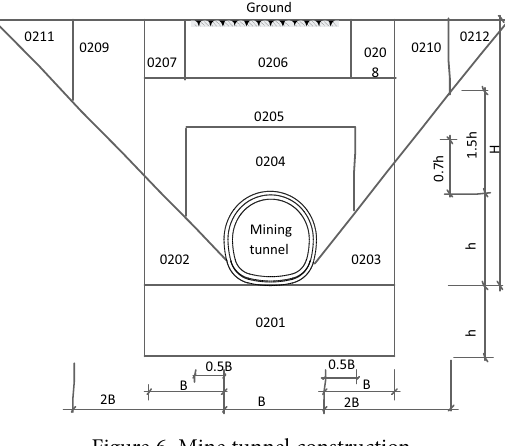
Figure 5. Shield tunnel construction Figure 6. Mine tunnel construction